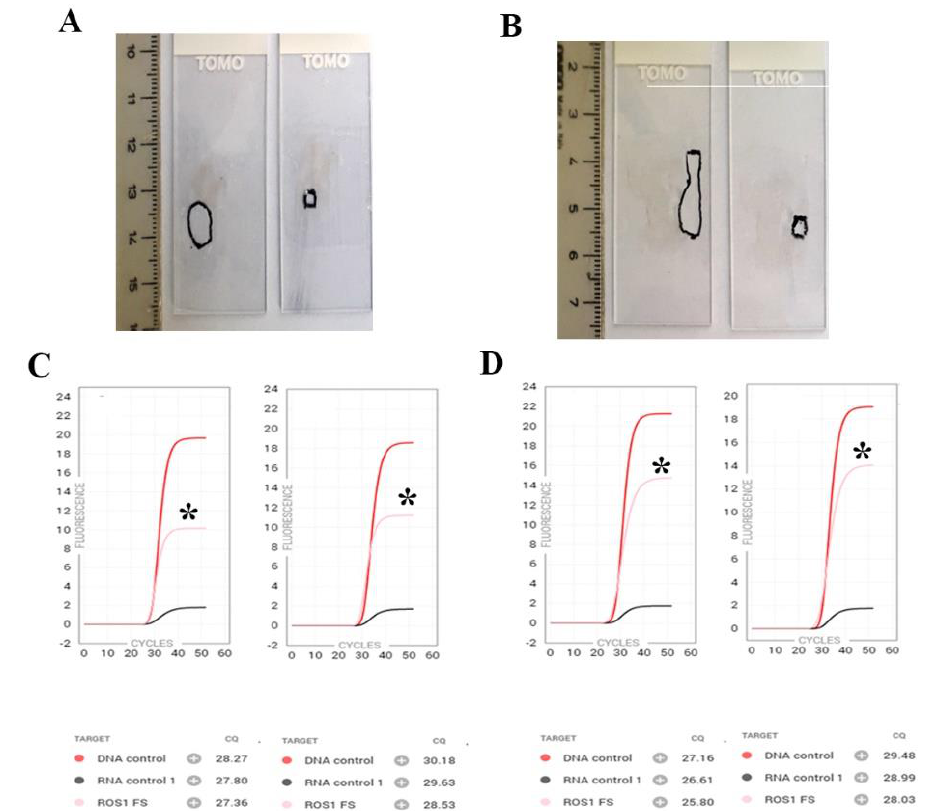
Figure 2. Reproducibility of the Idylla TM GeneFusion assay using tumor areas of different sizes. ( A , B ): larger and smaller microdissections from sequential sections of ROS1-positive cases #27 ( A ) and #28 ( B ); ( C , D ): corresponding Idylla GeneFusion plots showing ROS1 fusion-specific amplicons (black asterisks) in both specimens. Red curve: DNA control; black curve: RNA control; pink curve: ROS1 fusion-specific amplicon. The surface of microdissected area in panel ( A ): was 54 squared mm on the left and 9 squared mm on the right; in panel ( B ), the microdissected surface was 70 squared mm on the left and 12 squared mm on the right.